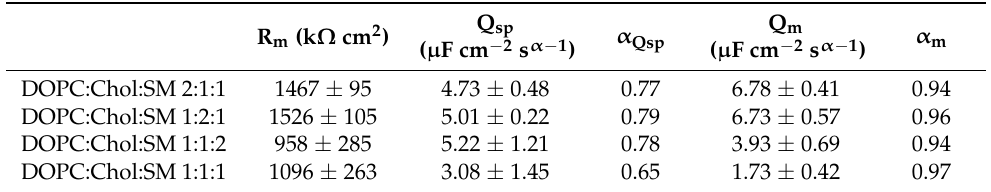
Figure 7. ( A ) Bode plots presenting logarithm of impedance and phase angle as a function of the frequency for proper bilayers at potential − 0.2 V vs. Ag|AgCl. Dots represent the measured spectra, while lines represent data obtained by fitting spectra to an equivalent circuit. Spectra obtained for DOPC:Chol:SM 1:1:2 (green), DOPC:Chol:SM 1:2:1 (red), DOPC:Chol:SM 2:1:1 (blue), DOPC:Chol:SM 1:1:1 (black) and ( B ) Equivalent circuit, used to fit obtained data, R sol and R m represent the resistance of solution and membrane, respectively, while Qm and Qsp are constant phase element of membrane and spacer between the bilayer and Au (111) surface. Table 1. Numerical values for the elements in the equivalent circuit used to model raft membranes (R m —resistance of membrane, Q m /Q sp —constant phase element of membrane/submembrane region, α Qm/ α Qsp empirical constant related to the frequency dispersion; experiments were performed at the potential of − 200 mV).